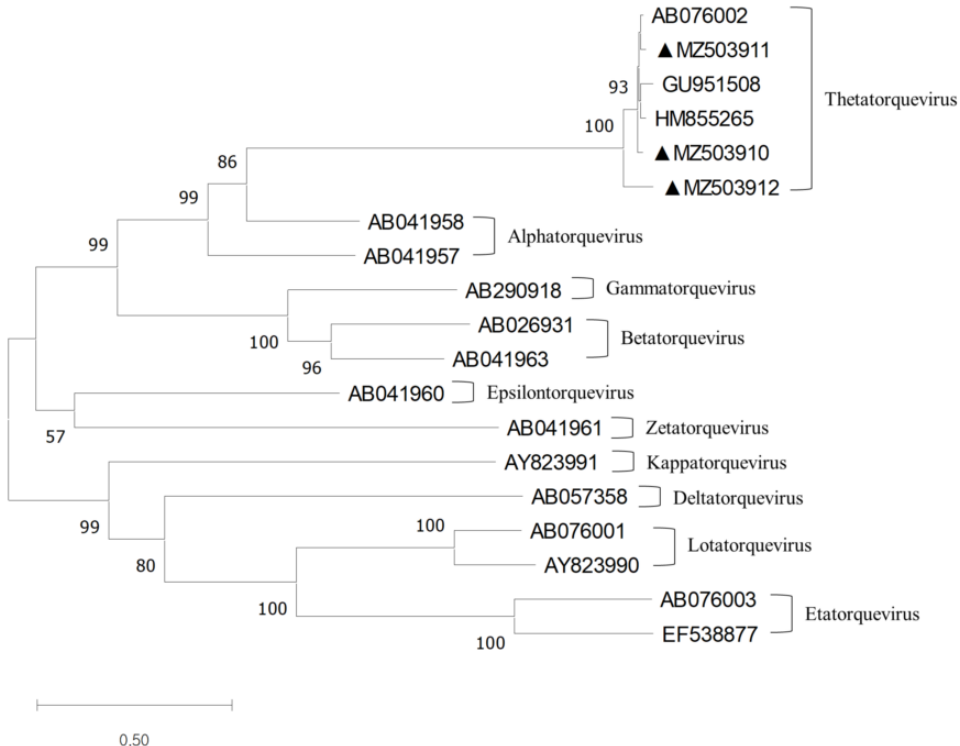
Figure 1. Phylogenetic tree constructed using the full-length TTCaV genomes and the reference TTV strain genomes. The maximum likelihood method and 1000 bootstraps were used. The branches with a bootstrap value greater than 70 were considered strong bootstrap support ( p < 0.05) [23]. The three TTCaV isolates identified in this study are marked with closed triangles and were grouped into Thetatorquevirus .